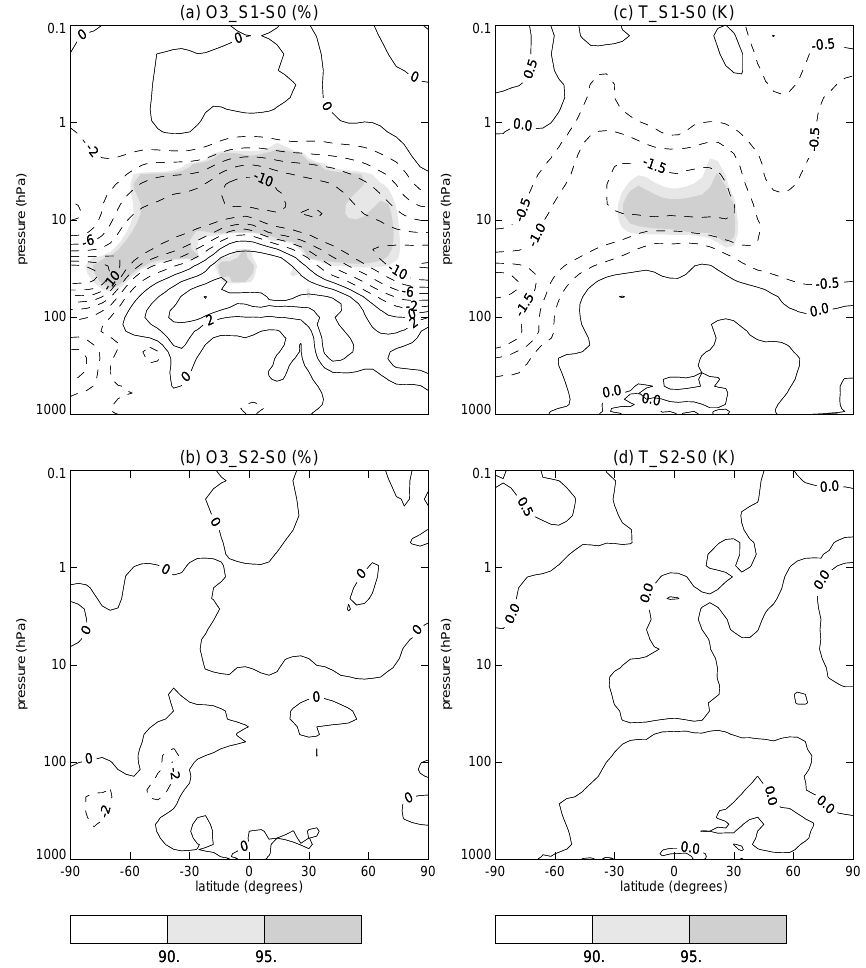
Figure 8. Latitude–pressure cross sections of zonal mean ozone differences (%) between WACCM sensitivity experiments (a) S1 and S0, and (b) S2 and S0, and temperature differences (K) between sensitivity experiments (c) S1 and S0, and (d) S2 and S0. The contour interval for ozone is 2% and for temperature is 0.5K. Grey colours represent statistical significance levels for the mean state differences between different simulations by Student’s t